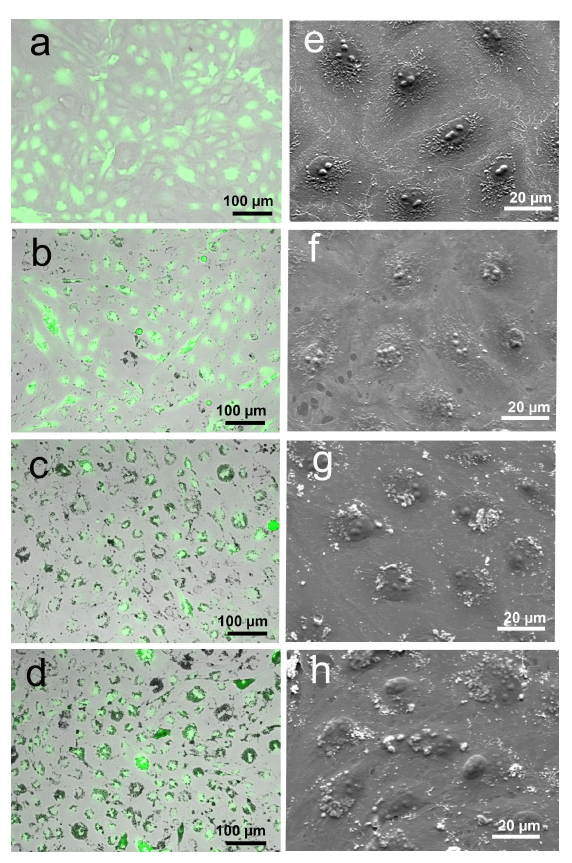
Figure 3: GFP labeled porcine aorta endothelial cells after three days of incubation with free GaN nanoparticles. Fluorescence (a–d) and SEM (e–h) images show the distribution of GaN nanoparticles and the morphological changes to endothelial cells upon exposure to GaN nanoparticles. The cells were exposed to either 10 µg/mL (b,f), 50 µg/mL (c,g), or 100 µg/mL (d,h) of GaN nanoparticles. Images a and e are negative controls treated with media alone.